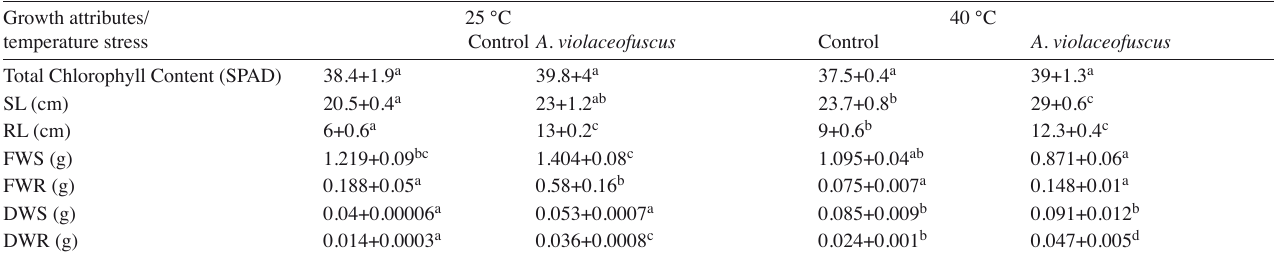
Tab. 3: Influence of A. violaceofuscus on the growth attributes of H. annuus . Growth